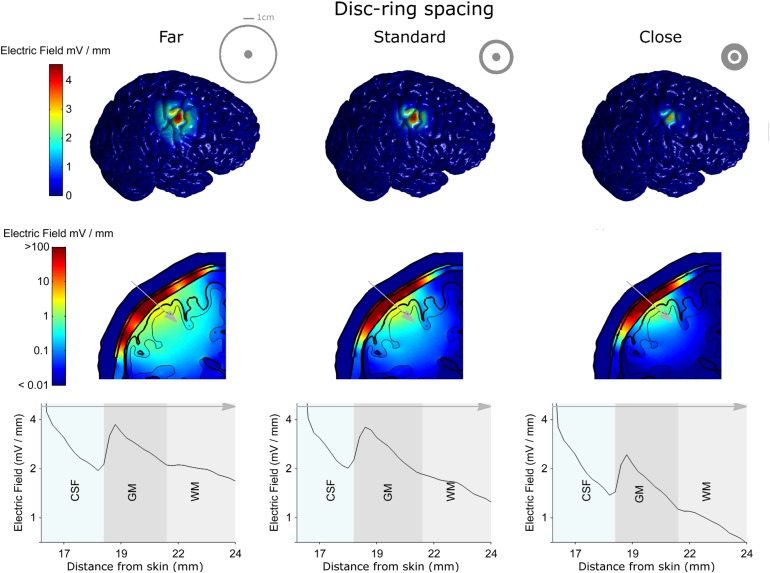
The electro-anatomical head model was used to investigate the effect of disc-ring spacing on the focality and strength of the electric field reaching the cortex. The left, central and right columns show model data for the far, standard and close disc-ring spacing respectively (shown as insets in the top row), when the same 1 mA current is delivered through each spacing. The top row shows how reducing the disc-ring spacing causes a more focused electric field on the brain. However, as highlighted in the second and third rows this comes at the cost of reducing the electric field strength. Thus, when keeping current constant, there is always a trade-off between electric field strength and focality. A 2-dimensional coronal, partial, cross-section is shown in the middle row using a logarithmic color scale. The different model tissues are outlined in black – skin, skull, CSF, gray matter (GM) and white matter (WM). A 1-dimensional plot of the electric field strength along the position indicated by the gray arrow is shown on the bottom row. This shows how the electric field magnitude decreases with distance from the electrode, how it is affected by each tissue type (only CSF, GM, and WM shown for a clearer comparison) and by the disc-ring spacing. Note that the maximum electric field values reported in the manuscript are based on the 3-dimentional brain volume (first row) and not on the 2-dimentional (second row) or the 1-dimensional (third row) as they represent values being interpolated from the 3-dimentional data.